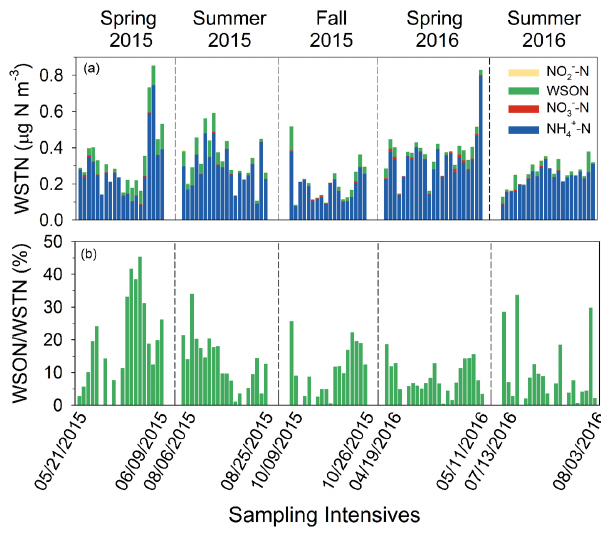
Figure 8. Contributions of N aerosol species to WSTN in 24h Hi- Vol PM 2 . 5 samples during seasonal SANDS intensives (a) along with the percentage contribution of WSON to WSTN (b) .